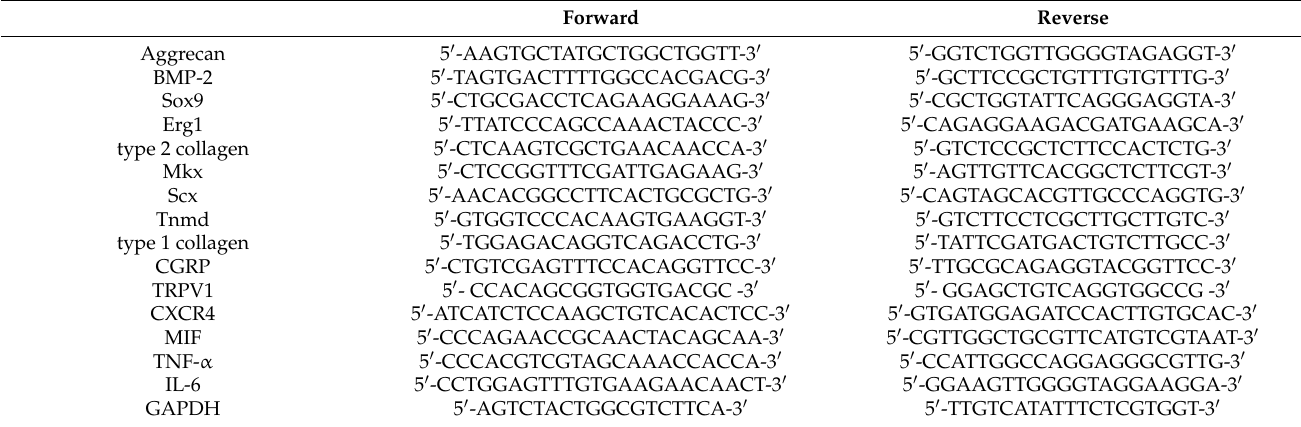
BMP-2, bone morphogenic protein-2; CGRP, calcitonin gene-related peptide; TRPV1, transient receptor potential vanilloid 1; CXCR4, C-X-C chemokine receptor type 4; MIF, macrophage migration inhibitory factor; TNF- α , tumor necrosis factor-alpha; IL-6, interleukin-6; GAPDH, glyceraldehyde 3-phosphate